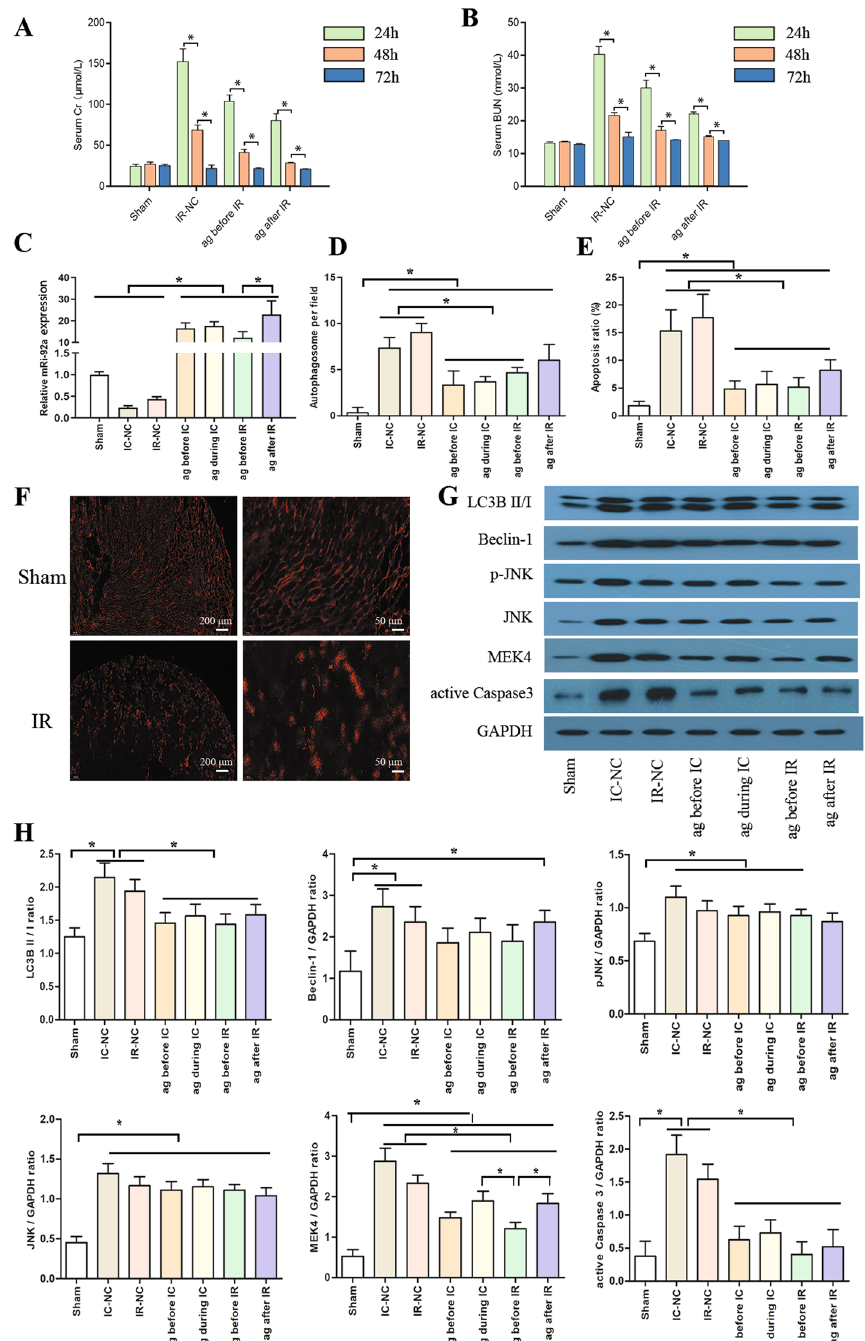
Fig. 4 Effect of miR-92a on IC and IR kidneys in mice. The content of serum Cr A and BUN B among groups. The expression of miR-92a C among groups. Each group’s number of autophagosomes D and kidney apoptotic rate E were compared. The kidneys homogeneously absorbed the Cy-3 labeled miR-92a-agomir injected via tail vein ( F ). In IC and IR mice treated with miR-92a agomir, the representative band G and statistical analysis H of LC3B II/I, Beclin 1, pJNK, JNK, MEK4, and active caspase 3 expression using Western blotting. * P < 0.05. ag 25 nM miR-92a agomir, BUN blood urea nitrogen, Cr creatinine, GAPDH glyceraldehyde phosphate dehydrogenase, IC ischemia and cold preservation, IR ischemia and reperfusion injury, JNK c-Jun NH [2] terminal kinase, LC3B microtubule-associated protein 1 light chain 3B, MEK4 mitogen-activated protein kinase, NC negative control, pJNK phosphorylated